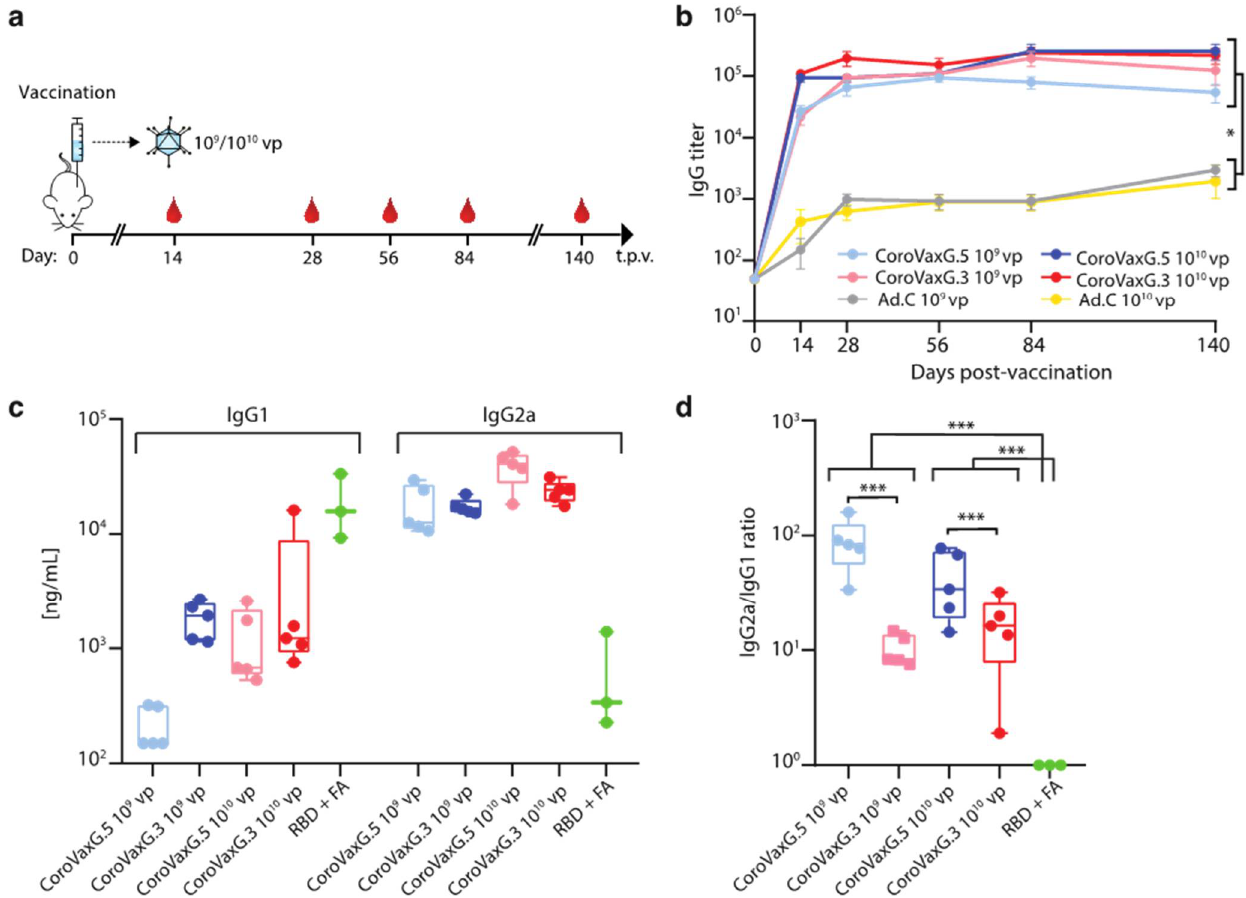
Figure 3. Immunogenicity and long-term humoral response induced by Ad-vectored vaccines. ( a ) Schedule of immunization and sample collection. Six-week-old BALB/c mice ( n = 5/group) received immunizations with 10 9 or 10 10 vp of an Ad-vectored vaccine. Sera were collected and assayed at the indicated time points (t.p.v. = time post vaccination). Animals were euthanized at 20 weeks post-vaccination (long term). Serum samples were used to ( b ) titer specific anti-S IgG, and ( c , d ) to assess the IgG1 and IgG2a anti-S concentration 28 days post-vaccination. The blue symbols correspond to CoroVaxG.5; the red symbols to CoroVaxG.3; and the grey and yellow symbols to Ad.C; the light symbols correspond to 10 9 vp and the dark symbols to 10 10 vp. ( b ) Data are means ± SEM (standard error of the mean). * p < 0.05; two-way ANOVA with Bonferroni correction ( c , d ). The box plots show the median, 25th and 75th percentiles, and the whiskers show the range. *** p < 0.001; one-way ANOVA with Brown–Forsythe test.